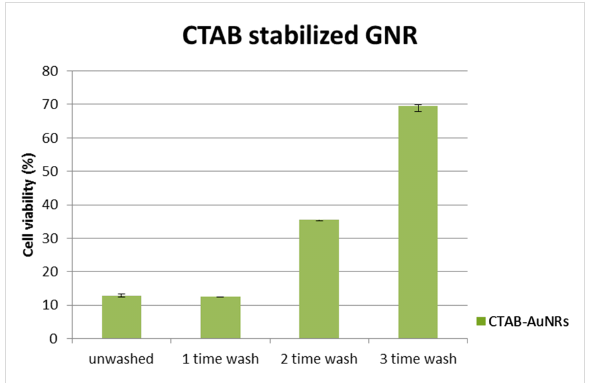
Figure 3: Relative cell viability of OSCC cells 24 h post-treatment. The cells were treated with as-synthesized AuNRs and AuNRs after different rounds of washing treatments.